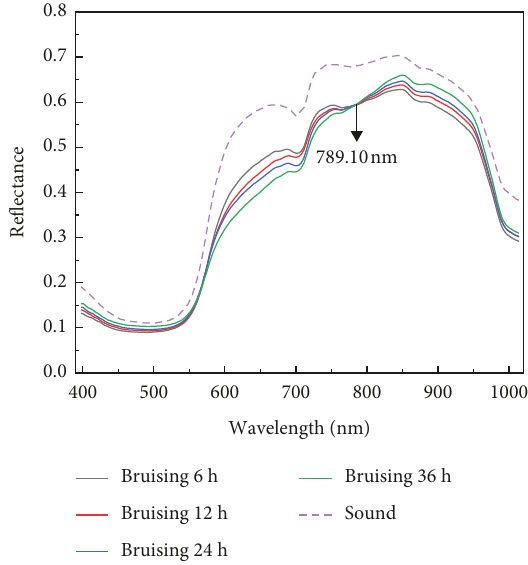
Figure 4: Spectral of samples with different bruise